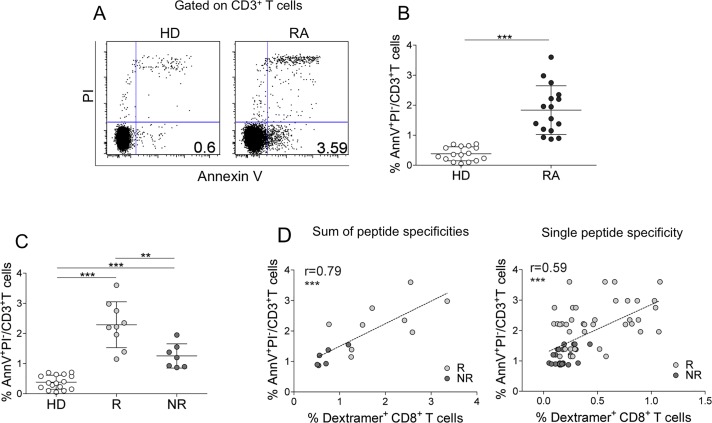
AE-specific CD8+ T cells correlate with circulating apoptotic T cells in RA patients (A-D).(A) Representative flow cytometry analysis of double-stained Annexin V/PI+ cells in CD3+ T cells from an HD or an RA patient. The percentage of Annexin V+/PI-cells is indicated in the appropriate quadrant. (B) Percentage of circulating early (Annexin V+/PI-) apoptotic T cells in 16 HDs and 16 RA patients studied. Statistical analysis was performed with the Mann-Whitney test. ***P < 0.0001. (C) Percentage of circulating early (Annexin V+/PI-) apoptotic T cells in all HDs and RA patients (9 Rs or 7 NRs to TNF-α inhibitor therapy) studied. Statistical analysis was performed with the Mann-Whitney test. **P < 0.001; ***P < 0.0001. (D) Correlation between circulating early apoptotic T cells and the sum of percentages of dextramer+CD8+ cells specific to a single epitope from the single R or NR (each symbol represents a single patient) (Spearman correlation analysis) (left graph); correlation between circulating early apoptotic T cells and percentage of all dextramer+CD8+ cells specific to a single epitope from R or NR (each symbol represents dextramer+CD8+ cells specific to a single AE) (right graph) (Spearman correlation analysis). Analyses were performed at time 0 (before the start of therapy).